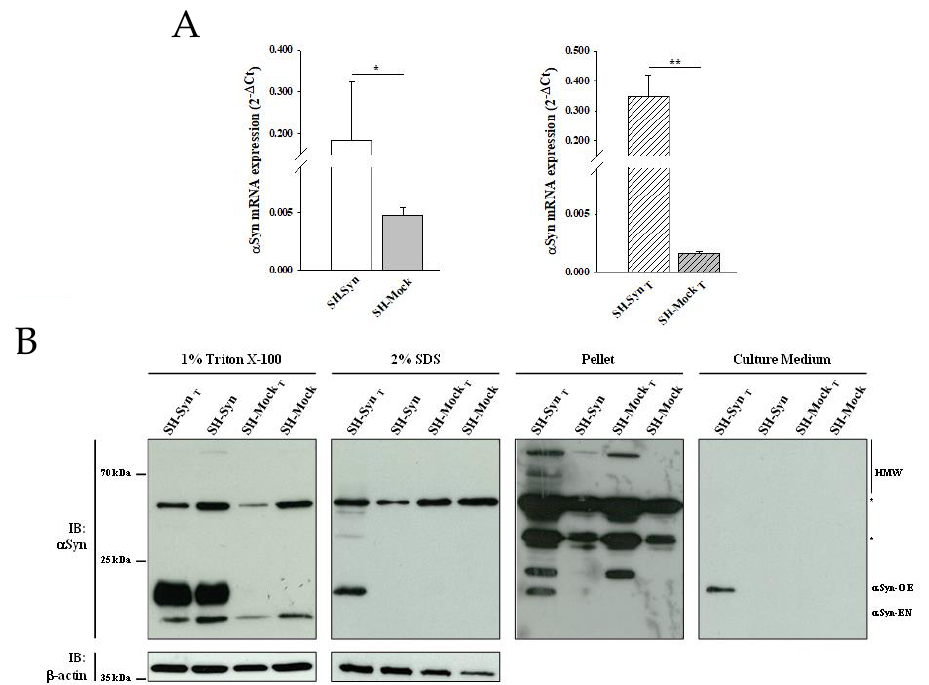
Figure 1. α Synuclein ( α Syn) expression in SH-SY5Y cells stably overexpressing α Syn (SH-Syn) and SH-Syn T . ( A ) α Syn mRNA quantification by qPCR in SH-Syn and control cells (SH-Mock) (left panel) and in SH-Syn T and SH-Mock T (right panel). Data are presented as the means ± SD from three independent experiments, each performed in duplicate. Data were analyzed by a two-tailed Student t -test (* p < 0.05; ** p < 0.001). ( B ) Detection of α Syn in the 1% Triton X-100 soluble fraction, in the 2% SDS soluble fraction, in the pellet fraction, and in the cell culture medium of SH-Syn, SH-Syn T , SH-Mock, and SH-Mock T . Blots are representative of experiments repeated three times. β -actin was used as the loading control; an asterisk represents non-specific